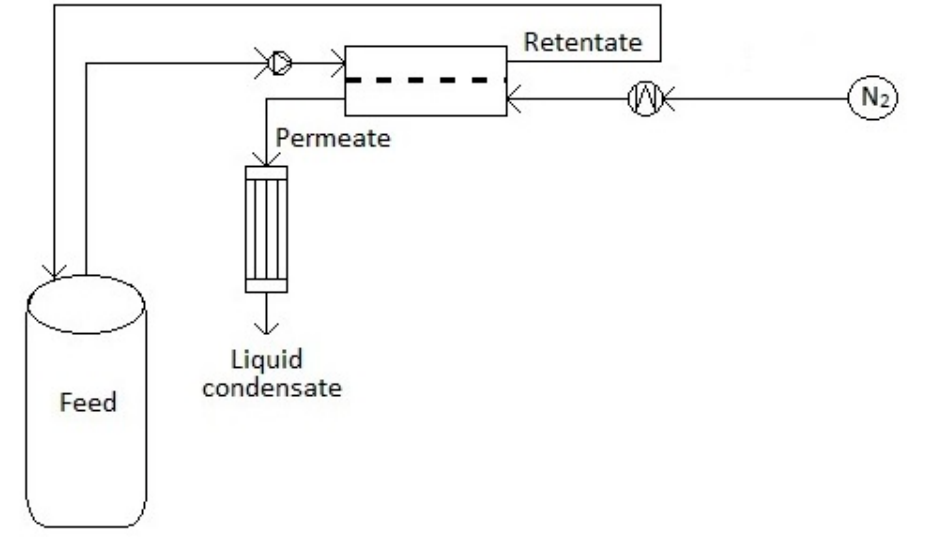
Figure 1. Schematic depiction of the cross-flow membrane separation apparatus used in this study.